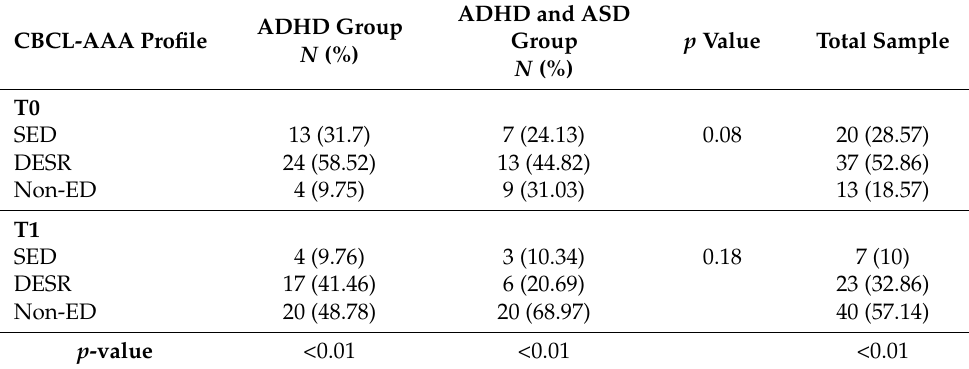
Table 3. Changes in CBCL-AAA profiles over 3 months of MPH treatment in the two groups.